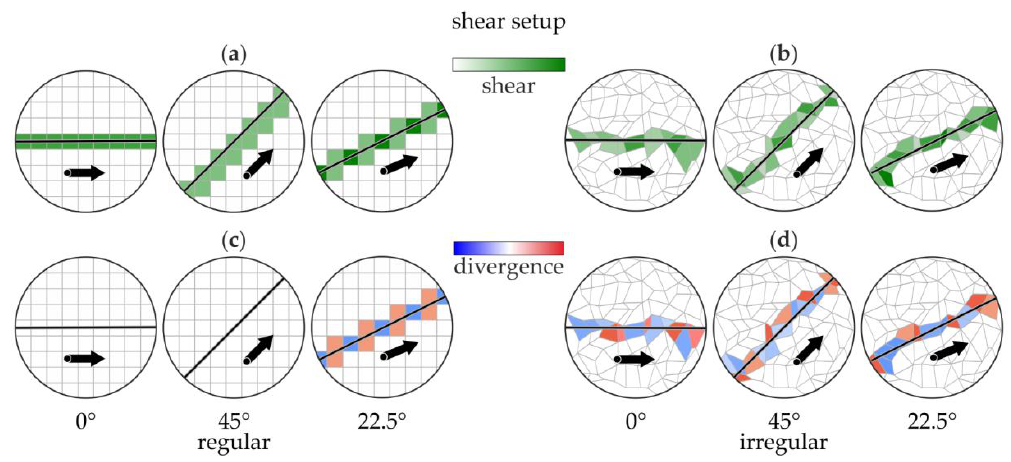
Figure 5. Example from results of the numerical shear experiment, here at rotation angles 0°, 22.5°, and 45°. Parameters shear and divergence in a regular ( a and c ) and an irregular ( b and d ) grid, respectively. Openings are shown in blue and closings in red.